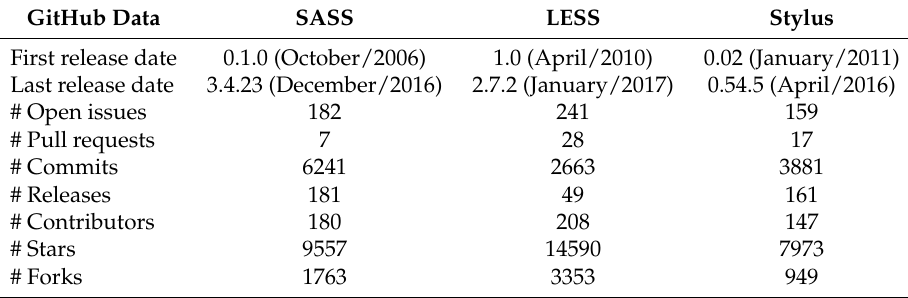
Table 2. CSS Processors Maturity.